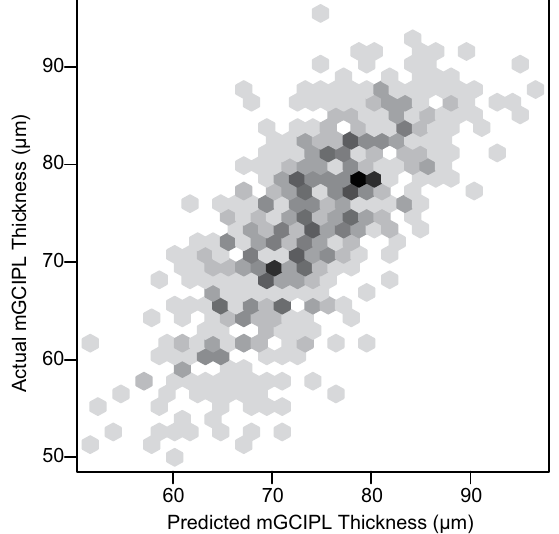
Figure 1. Scatterplot showing relationship between average mGCIPL thicknesses predicted by HDLM and actually measured by SD-OCT. A strong correlation was found between the predicted and the measured mGCIPL thicknesses (Pearson’s correlation coefficient = 0.739; R 2 = 0.545). (mGCIPL = macular ganglion cell- inner plexiform layer; HDLM = hybrid deep learning model; SD-OCT = spectral domain-optical coherence tomography).